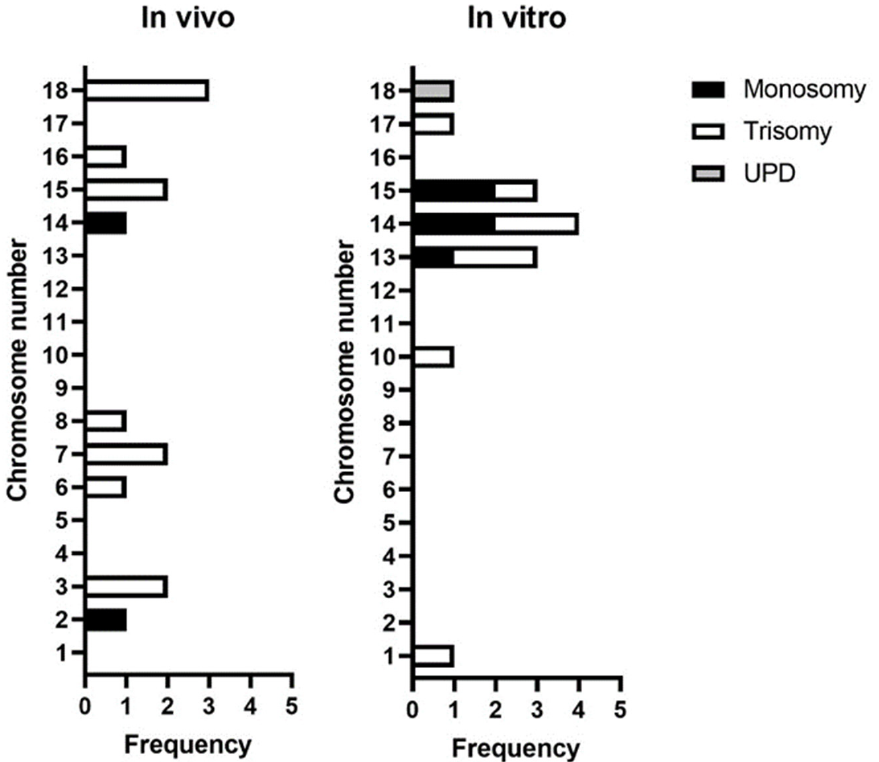
Figure 6. Frequency of whole chromosome errors for in vivo-derived embryos ( n = 14 whole chromosomal total errors) and in vitro-produced blastocysts ( n = 14 whole chromosomal total errors).